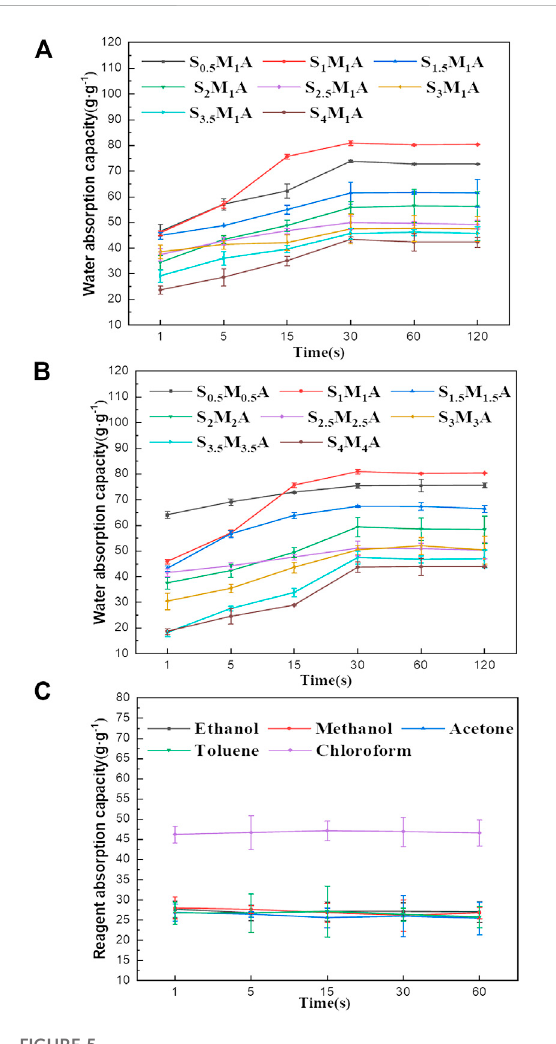
FIGURE 5 (A) Watersorptionkineticsofcompositeaerogelspreparedat 1 wt% CMC solution and different CS solutions, (B) water sorption kinetics of composite aerogels prepared at different mass concentration, (C) the sorption kinetics of S 1 M 1 A for the fi ve types of organic